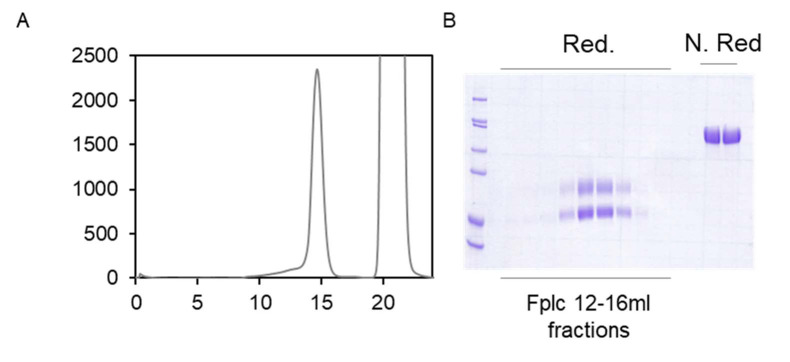
Evolution of peptide-Ab yeast display.(A) Size exclusion chromatography of the vTreg53 TCR following purification by Ni-NTA column and overnight biotinylation using BirA enzyme. (B) Reducing and non-reducing SDS-PAGE of the vTreg53 TCR fractions collected in (A).